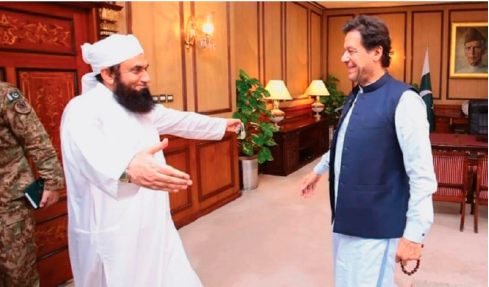
Figure 12. Maulana Tariq Jamil and Imran Khan, during the time of his premiership. Source: https://www.dawn.com/news/1630280. As part of his drive to recruit high-profile public figures to the Tablighi cause, Mau- lana Tariq Jamil has not shied away from meeting female showbiz celebrities including actresses, singers, and talk-show hosts. This signals another departure from classical Tablighi policy which advocates strict gender-segregation when engaging in da’wa . In 2014 however, Jamil visited the provocative Pakistani actress Veena Malik at her Dubai residence who, soon after in a televised interview, caused a media storm by attributing her new-found religiosity to Jamil and referring to him as her “spiritual father” (https://www.dailymotion.com/video/x1a244h). The Maulana has also interacted with other well-known figures such as popular Punjabi stage dancer Nargis, who accompanied